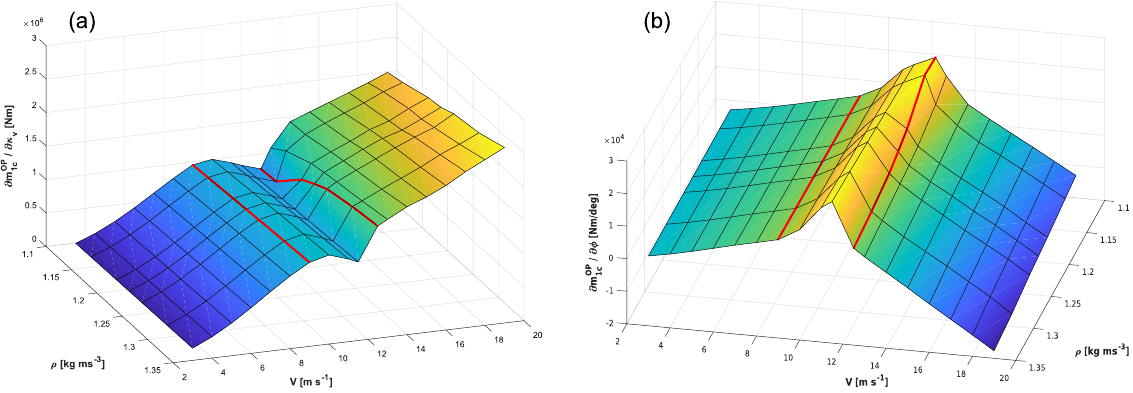
Rev cosine × and III are indicated by 2